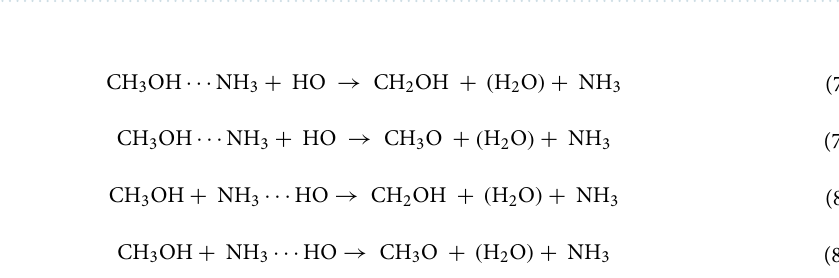
Figure 3. Potential energy surface for ammonia-assisted OH + CH 3 OH reaction obtained using CC//M06-2X with 6-311++G(3df,3pd) basis set. The relative energies include zero-point